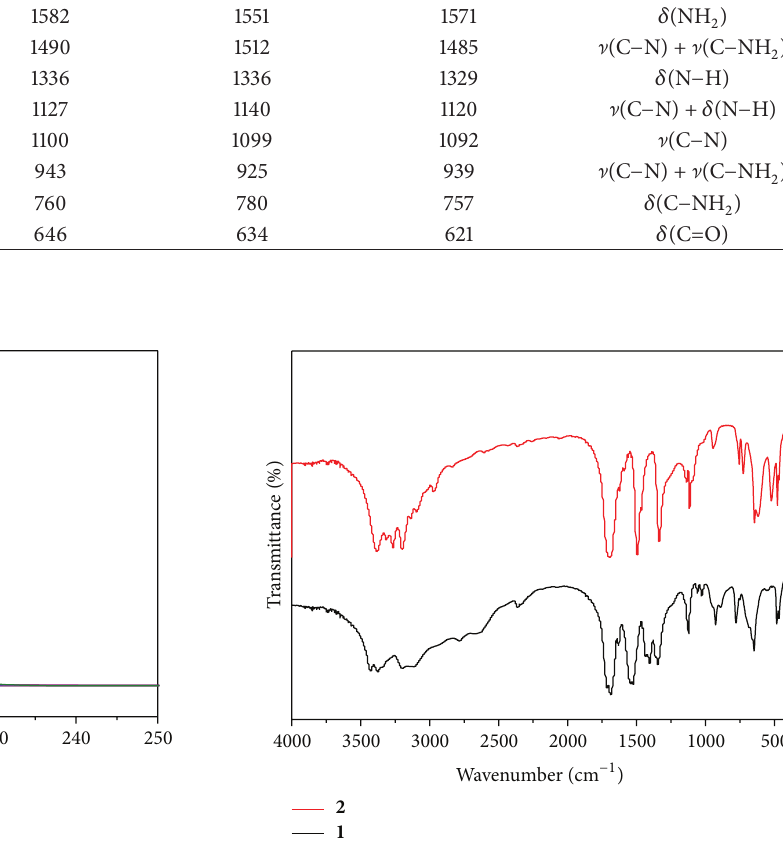
Figure 2: IR spectra of complexes 1 and 2